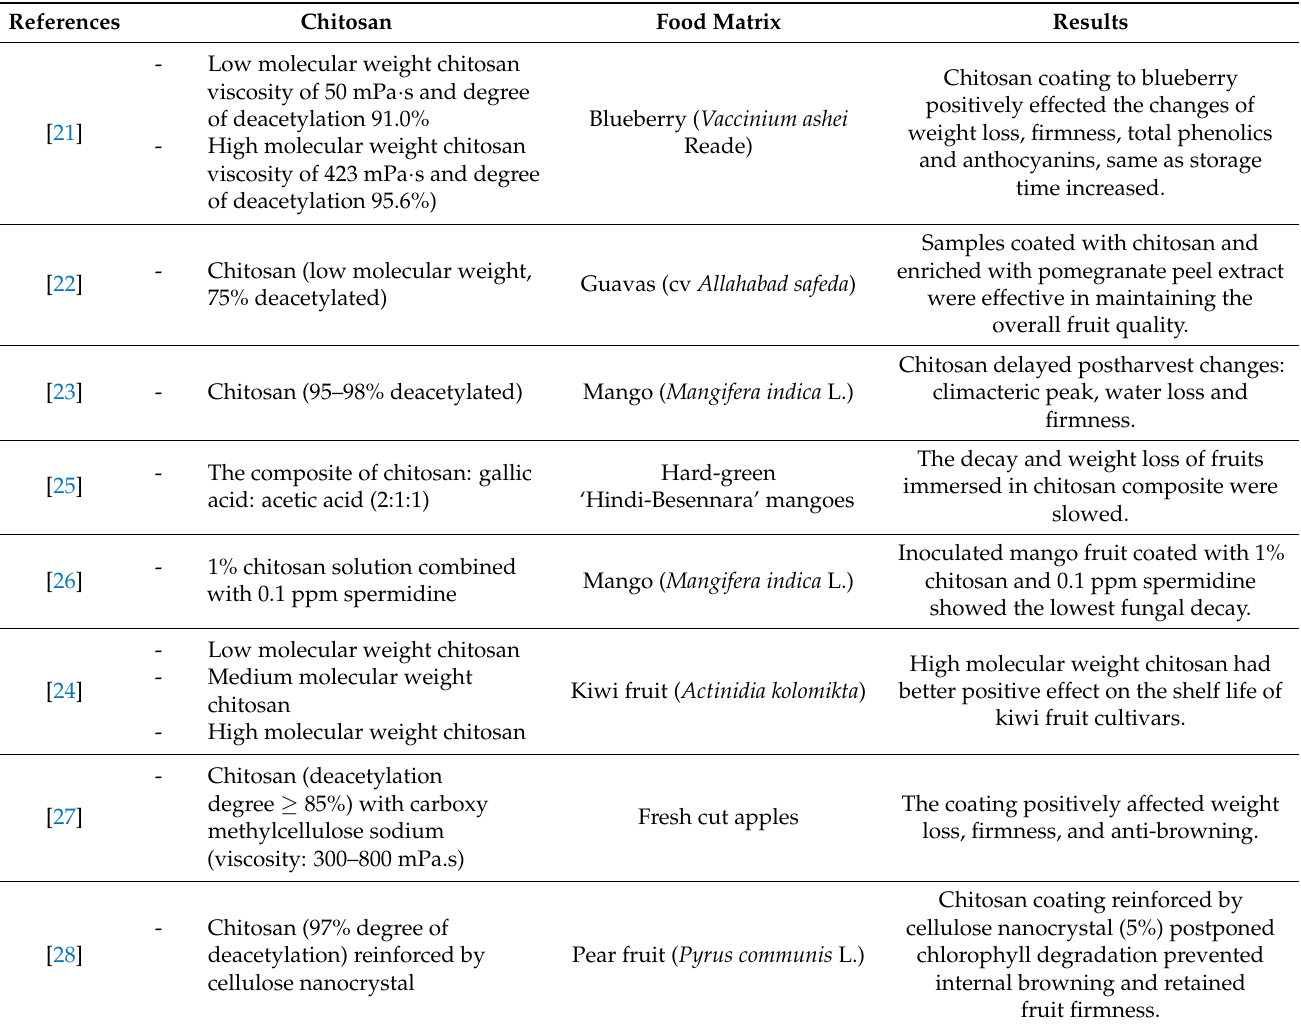
Table 1. A brief review of chitosan-based coatings applied on